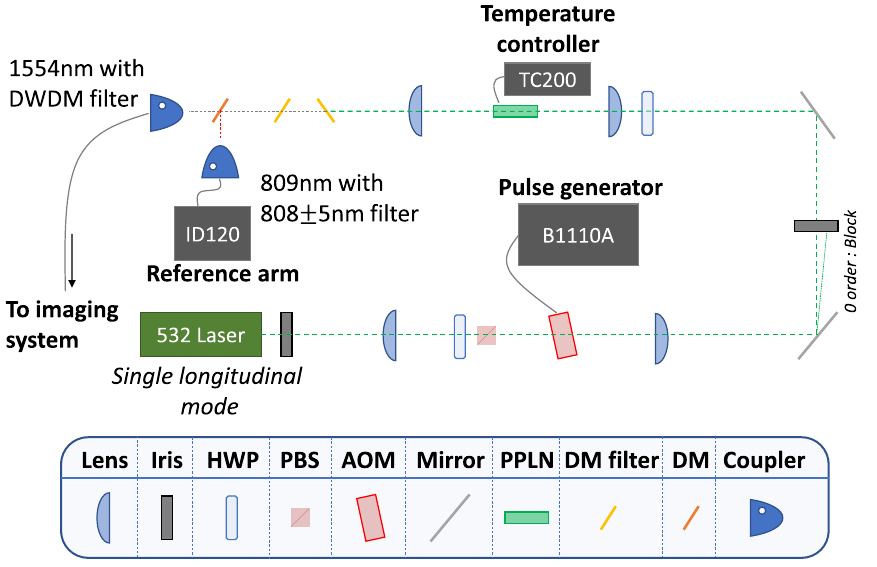
Figure 6. Schematic diagram of heralded photon-pair generation. Pairs of 1554-nm signal photon and 809-nm idler photon are generated by SPDC using a 532-nm pump laser (MSL-F-532; CNI). Two dichroic mirrors remove the pump laser, and each photon is filtered with DWDM ITU Ch29 and 808 ± 5 nm narrow bandpass filters. Iris Iris pinhole, HWP half-wave plate, PBS polarization beam splitter, AOM acoustooptic modulator, PPLN periodically poled lithium niobate crystal, DM dichroic